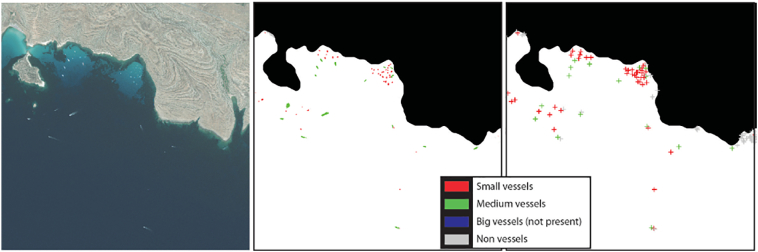
Example of vessel classification on a GeoEye-1 image of Lampedusa (Italy) based on the vessel size. Left: input image. Middle: classified segments with the land removed. Right: classified targets marked with crosses. Small (red) vessels represent detected segments smaller than 20 m, medium (green) between 20 m and 100 m, and big (blue) vessels are the ones measuring more than 100 m. (For interpretation of the references to color in this figure legend, the reader is referred to the web version of this article.)